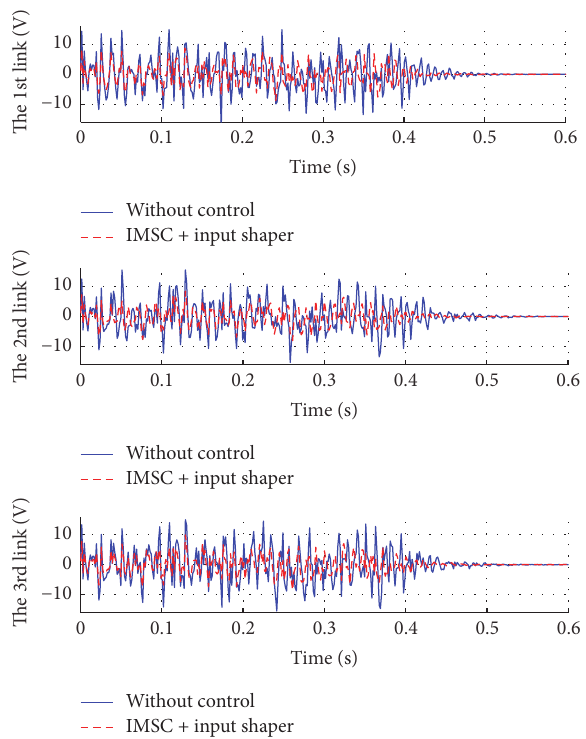
Figure 12: Response voltages of the PZT sensors at 150 mm of the three